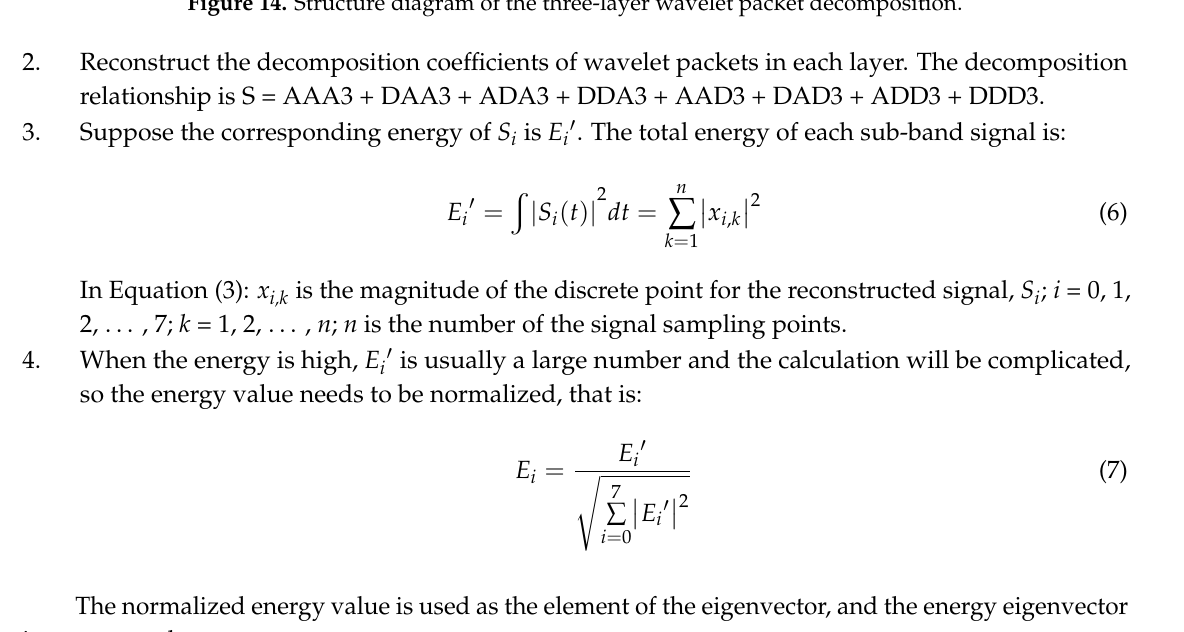
Figure 14. Structure diagram of the three-layer wavelet packet decomposition.